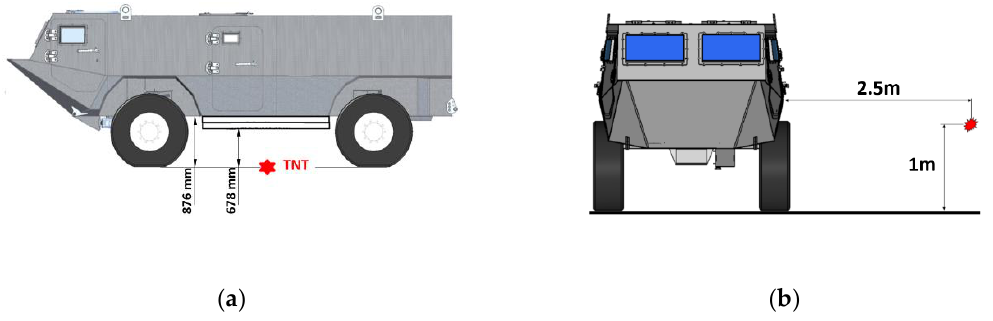
Figure 5. Way of placing the explosive towards the vehicle: ( a ) central explosion, ( b ) explosion next to the vehicle.